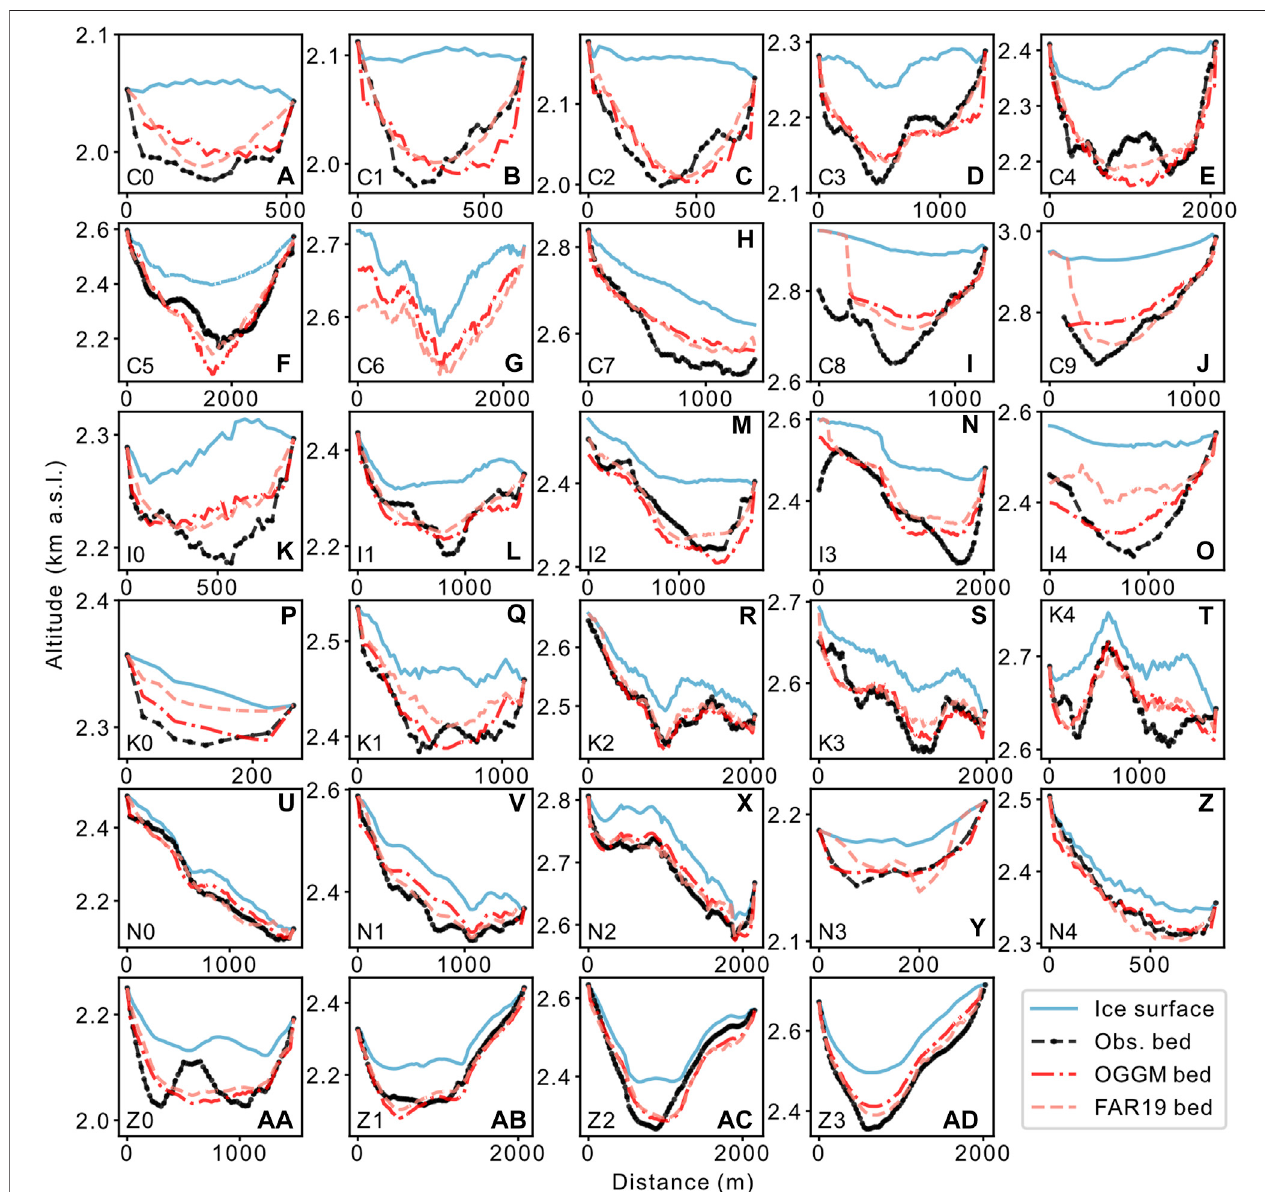
FIGURE 3 | Flux gate cross-sections for (A – J) Conrad, (K – O) Illecillewaet, (P – T) Kokanee, Nordic (U – Z) , and Zillmer (AA – AD) glaciers. Gates are numbered according to glacier, e.g., Conrad gate 0 (cid:3) C0.